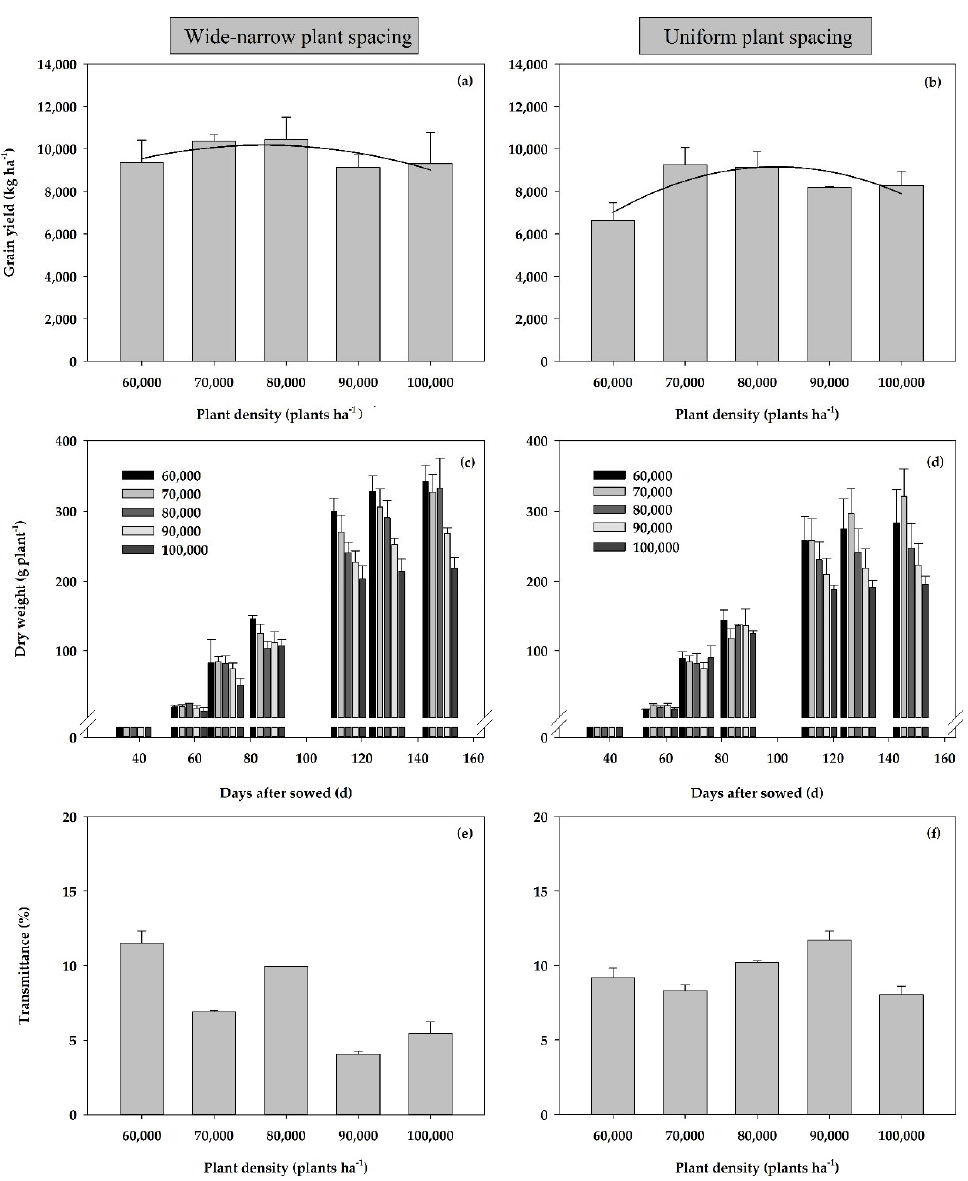
Figure 1. Dynamics of dry matter weight, transmittance of canopy and variation of yield with plant density under wide ‐ narrow ( a , c , e ) and uniform plant spacing ( b , d , f ).